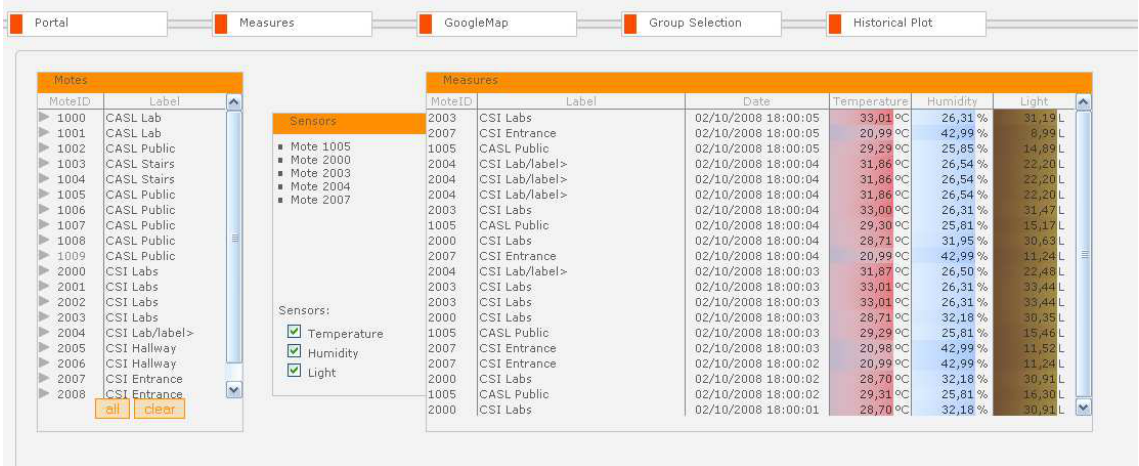
Figure 10. Real-time viewing of sensor